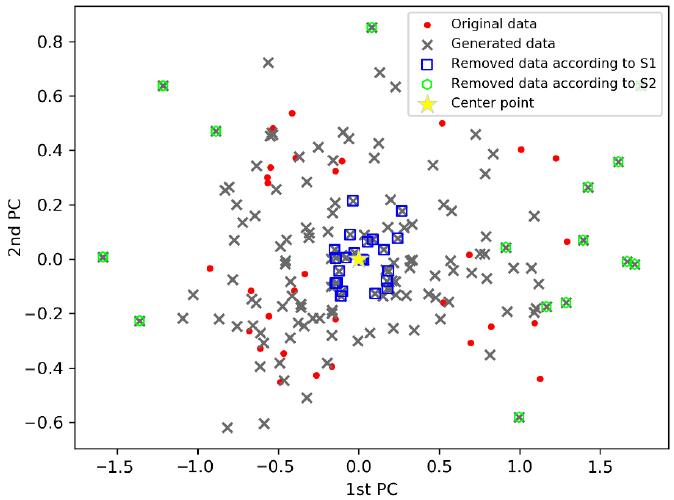
Figure 9. Scatter distribution comparison of the qualified virtual samples for the polyethylene process.